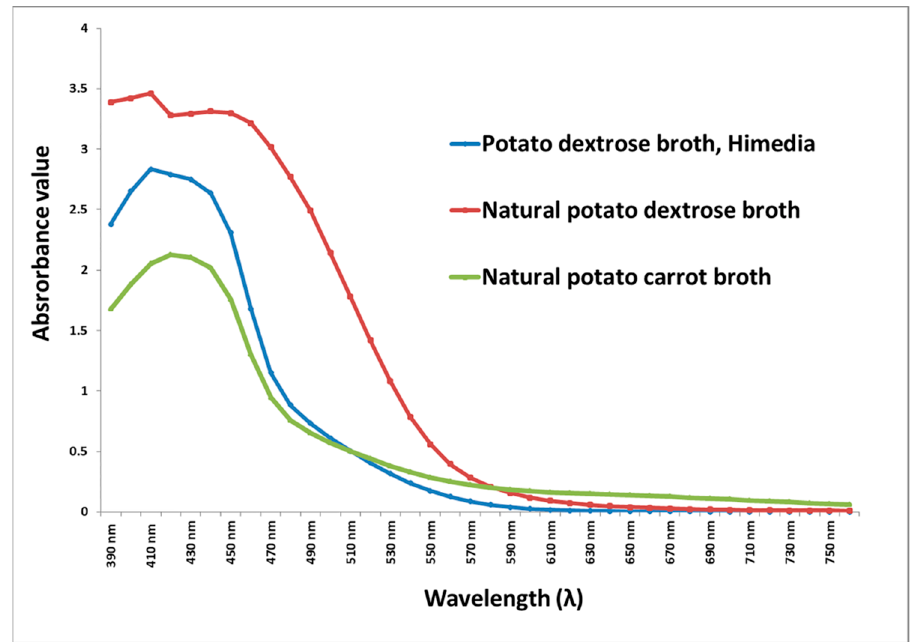
Figure 5. UV–Vis spectroscopy scanning (390–760 nm) of culture filtrates of different media.